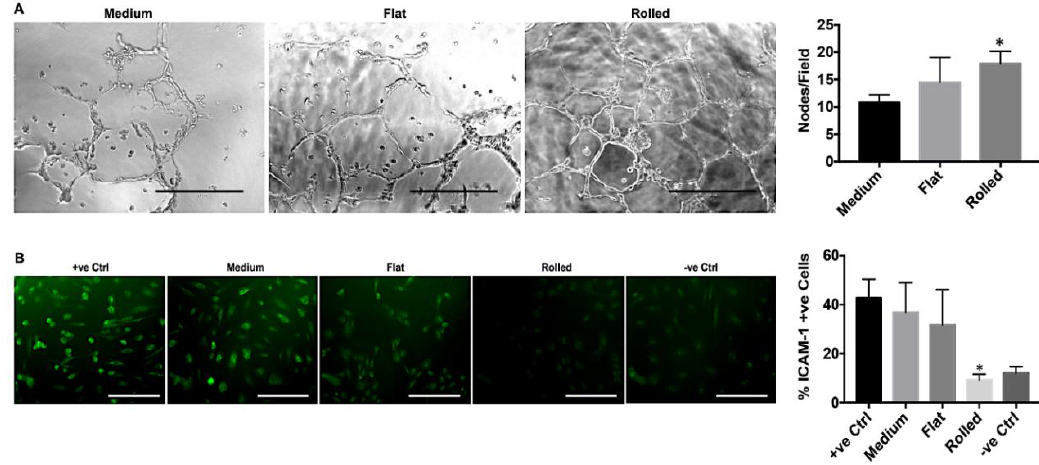
Figure 6. Conditioned medium from DC sca ff old in rolled configuration enhances angiogenesis and reduces TNF α -mediated inflammation on endothelial cells. The conditioned media from the flat and rolled sca ff old culture conditions collected were tested for their pro-angiogenic and anti-inflammatory potentials. Angiogenesis assay was performed using Matrigel and HUVECs. ( A ) Brightfield images showing tube formation of HUVECs in response to CM from flat and rolled sca ff olds after 16 h of incubation. SmGM-2 from acellular sca ff old was used as a control medium. The scale bar represents 200 µ m. The graph represents number of nodes / field ( n = 4, Rolled vs. Flat p > 0.05; Rolled vs. Medium p < 0.03; Flat vs. Medium p > 0.05). TNF α of 50 ng / mL was used to induce inflammation in HUVECs and then were treated with conditioned media from flat and rolled sca ff olds. Control groups were TNF α alone, no TNF α and SmGM-2 from an acellular sca ff old. The expression of ICAM-1 was detected and quantified. ( B ) Immunostaining of HUVECs with ICAM-1 and the representative graph shows the percentage of cells positive for ICAM-1 ( n = 4, Positive control vs. Negative control p < 0.0003; Rolled vs. Positive control < 0.002; Medium control vs. Flat p > 0.05). Statistical analysis was performed using one-way ANOVA. * denotes statistical